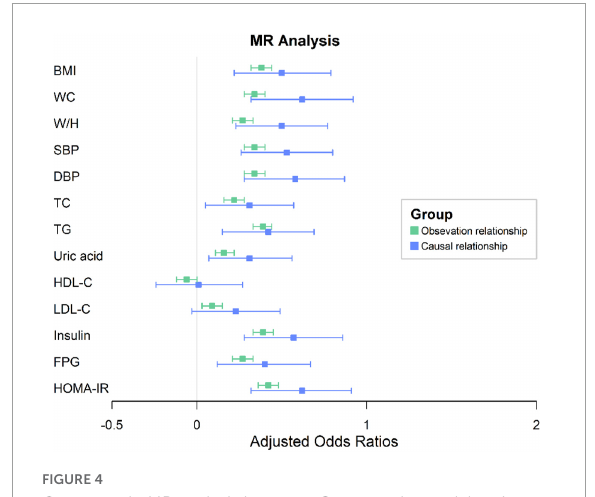
FIGURE4 One-sample MR analysis between Gamma-glutamyl-leucine (Gamma-Glu-Leu) and cardio-metabolic risk factors. Colors in green denote the observational relationships. Colors in blue denote the causal relationships. The error bar signifies the beta and 95% CIs. Beta was adjusted for age and sex; BMI, body mass index; WC, waist circumference; W/H ratio, waist circumference to hip circumference ratio; SBP, systolic blood pressure; DBP, diastolic blood pressure; TG, triglycerides; HDL-C, high density lipoprotein cholesterol; TC, total cholesterol; LDL-C, low-density lipoprotein cholesterol; HOMA-IR, homeostasis model assessment of insulin resistance; MR, Mendelian Randomization; CI, confidence